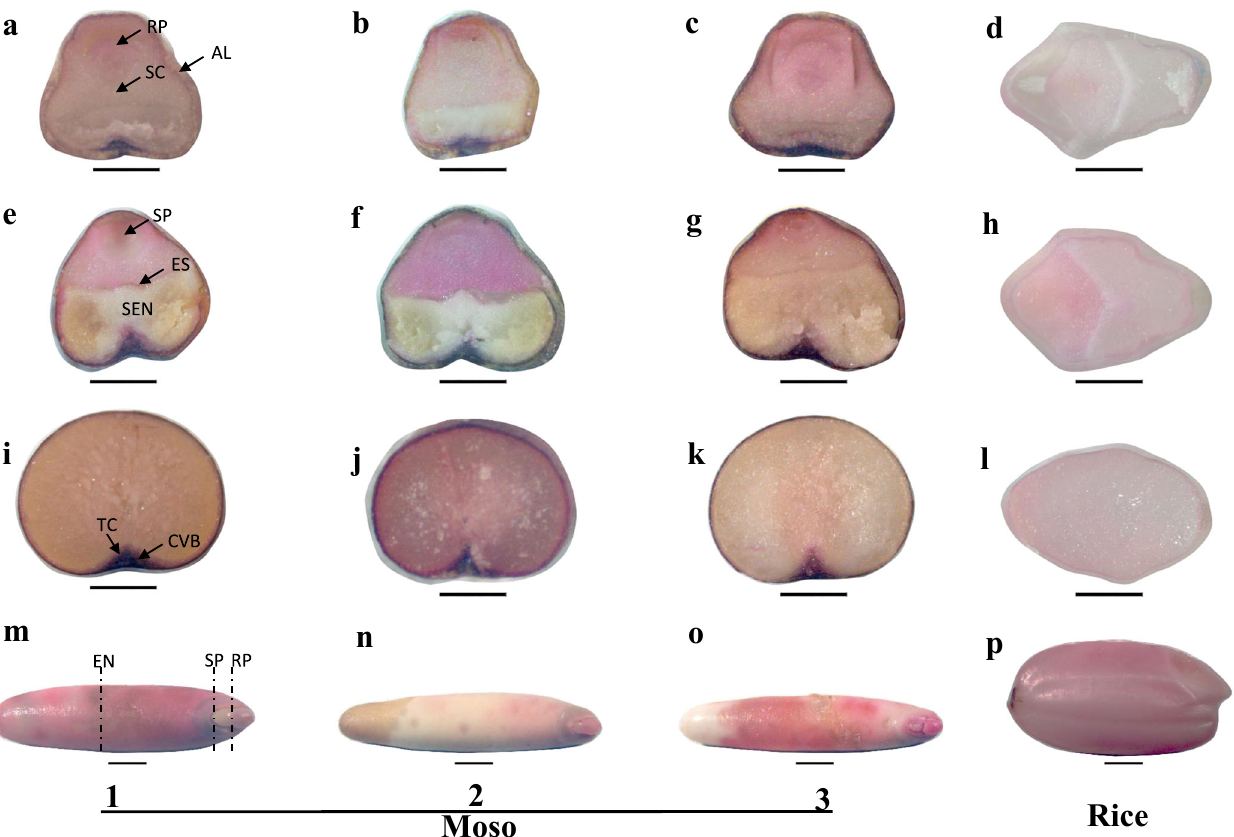
Fig. 5 Localisation of Zn in Moso bamboo seeds and rice. Zn in transverse sections of root primordium ( a , b , c , d ), shoot primordium ( e , f , g , h ), and endosperm ( i , j , k , l ) of Moso bamboo seeds ( a , b , c , e , f , g , i , j , k ) and rice ( d , h , l ) were stained by dithizone staining. RP root primordium; SP shoot primordium; EN endosperm; SEN starchy endosperm; SC scutellum; ES epithelium of scutellum; AL aleurone layer; TC transfer cell; CVB crease vascular bundle. Scale bars = 1000 μ